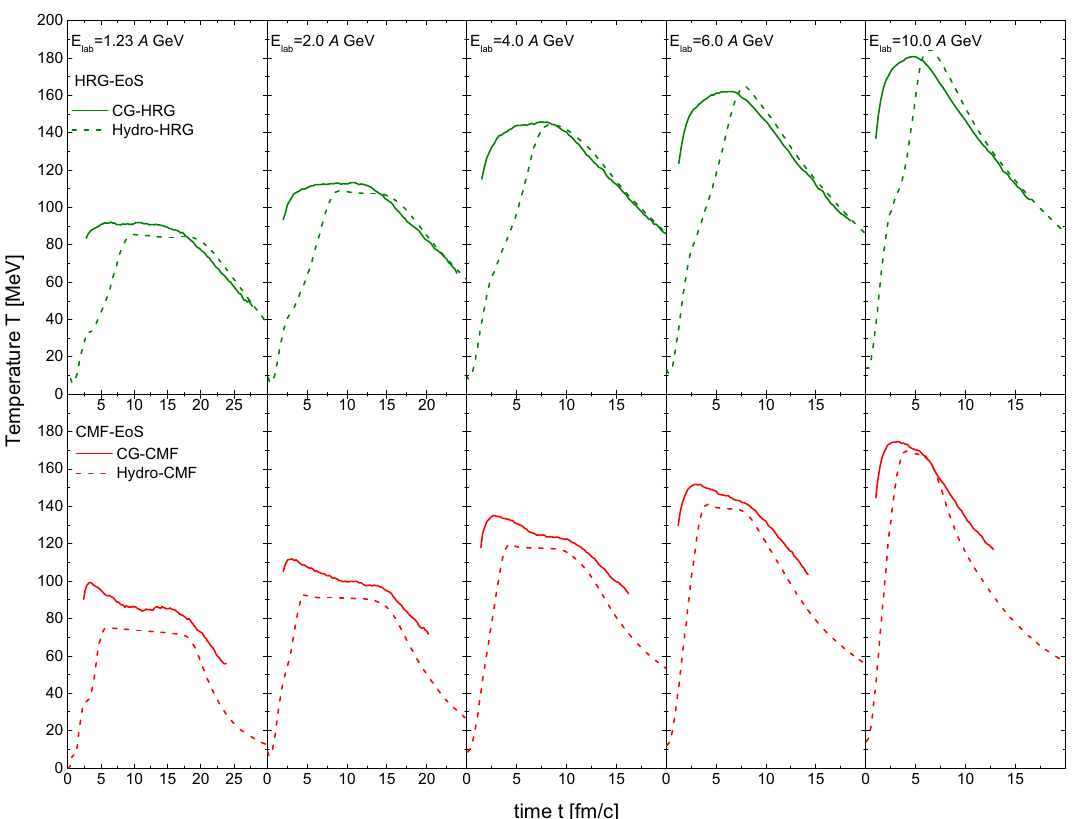
time t [fm/c] row are calculated using the hadron resonance gas EoS in hydro and for the conversion from (ε,ρ B ) to the thermodynamic quantities, while the red lines in the lower row show the results for the CMF EoS. In the coarse-graining procedure, only participants are used for the averaging, so the Temperature appears to ‘jump’ to a finite